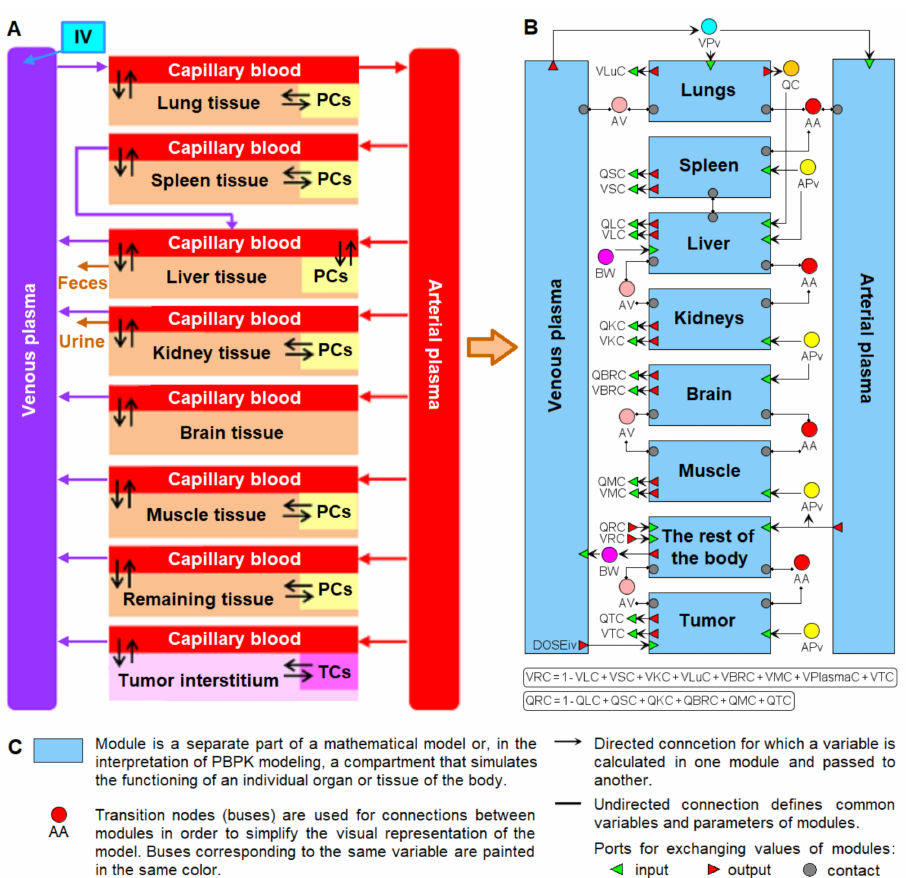
Figure 7. The final BioUML representation of the PBPK model of nanoparticle delivery to solid tumors in mice. ( A ) Original schematic diagram by Cheng et al. (Used with permission from https://pubs.acs.org/doi/10.1021/acsnano.9b08142 accessed on 1 April 2022. Copyright (2020) American Chemical Society. Further permissions related to the material excerpted should be directed to the American Chemical Society). ( B ) Implementation of the modular computational model in BioUML by analogy with the scheme A ( C ) Graphical notation used in BioUML to represent the